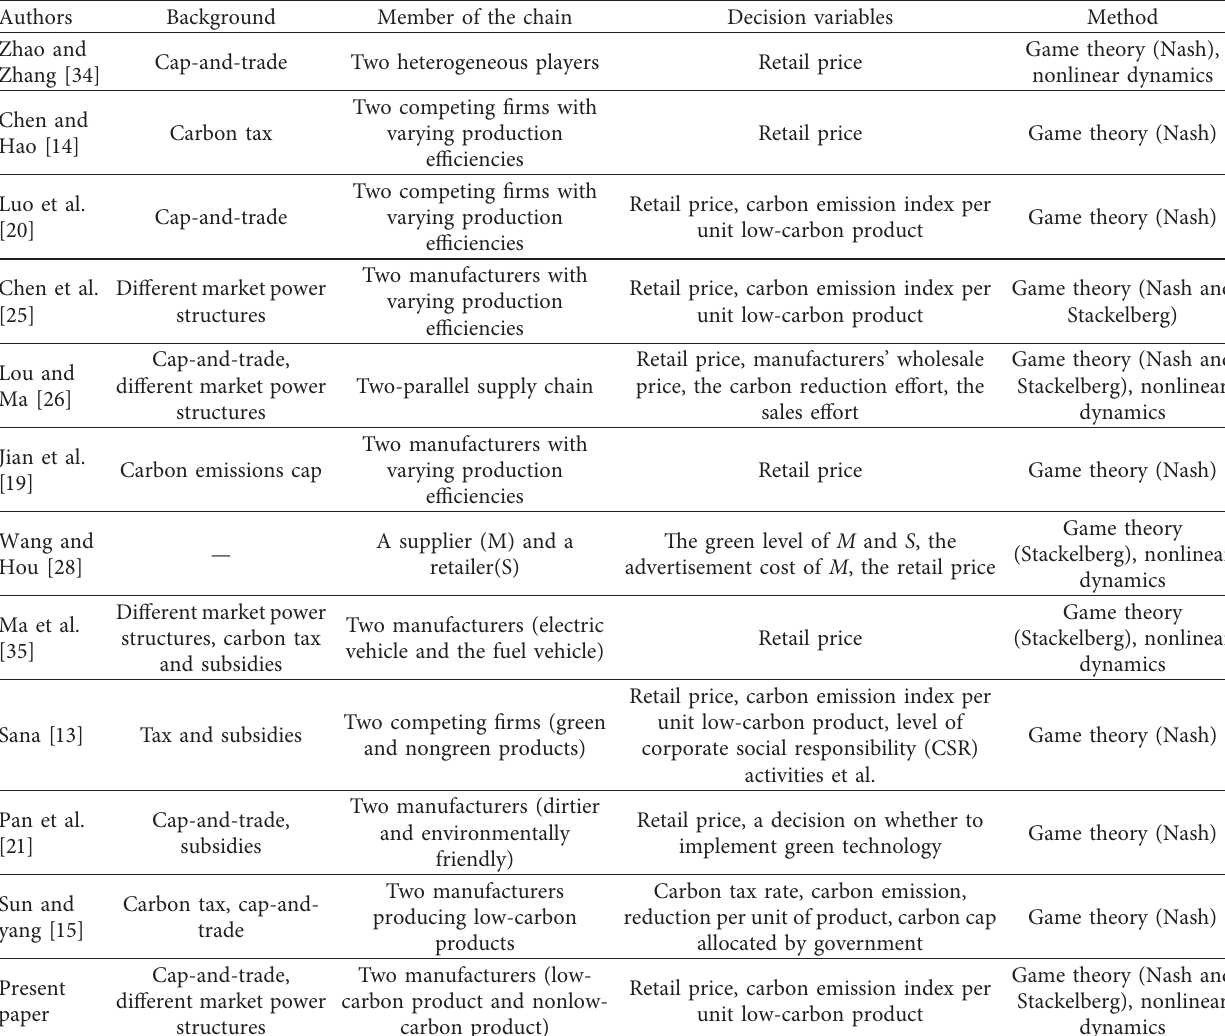
Table 1: Comparison of existing models with this